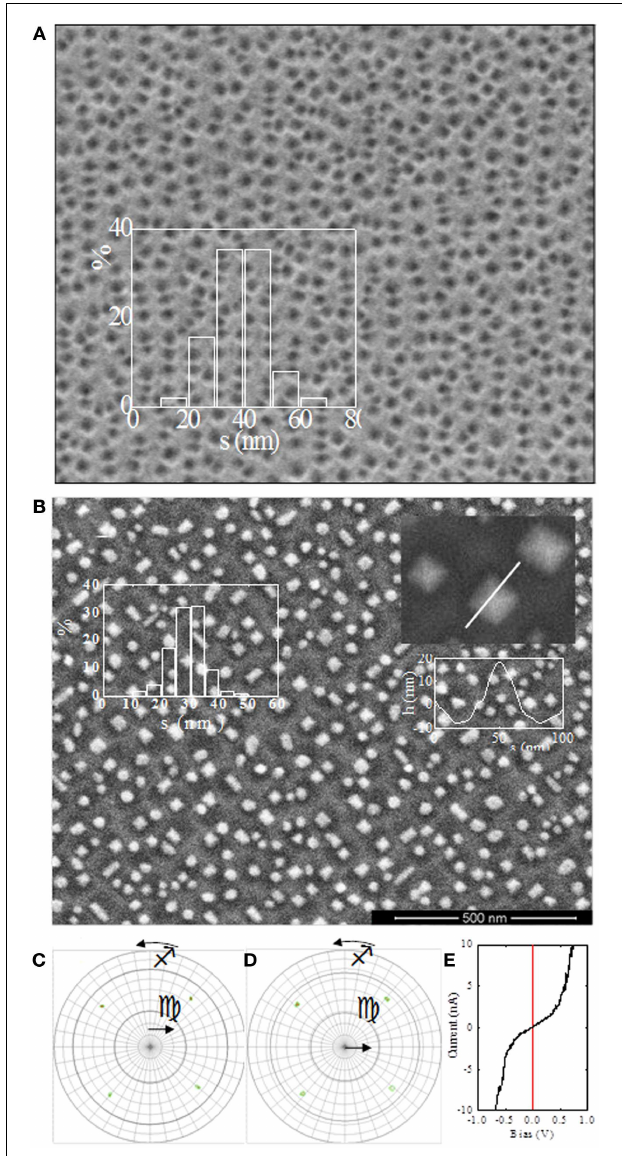
FIGURE 2 | (A) Scanning electron micrograph showing self-organized nanopits on the surface of a La 0.7 Sr 0.3 MnO 3 film. Inset shows the nanopit size distribution histogram. (B) Scanning electron micrograph of the Au nanocrystals grown inside the nanopits. Upper left inset shows the size distribution histogram of the Au nanocrystals. Upper right inset: upper panel is a magnified image of an Au nanocrystal exhibiting octahedral shape; lower panel shows a typical atomic force microscopy topographic profile of one Au nanocrystal. (C,D) (111)-X-ray diffraction pole-figures corresponding to the La 0.7 Sr 0.3 MnO 3 film and the Au nanocrystals, demonstrating their cube-on-cube epitaxial relationship. (E) I – V curves obtained by using atomic force microscopy in current sensing mode when the conducting tip is placed directly on top of the bare La 0.7 Sr 0.3 MnO 3 surface (black curve) or on top of an Au nanocrystal (red curve).The black curve exhibits the typical features of tunneling conduction, resulting from the deterioration of the La 0.7 Sr 0.3 MnO 3 surface, while the red curve exhibits metallic-like behavior, indicating that the Au nanocrystals protect the La 0.7 Sr 0.3 MnO 3 surface against degradation due to ambient conditions (from Konstantinovic et al.,